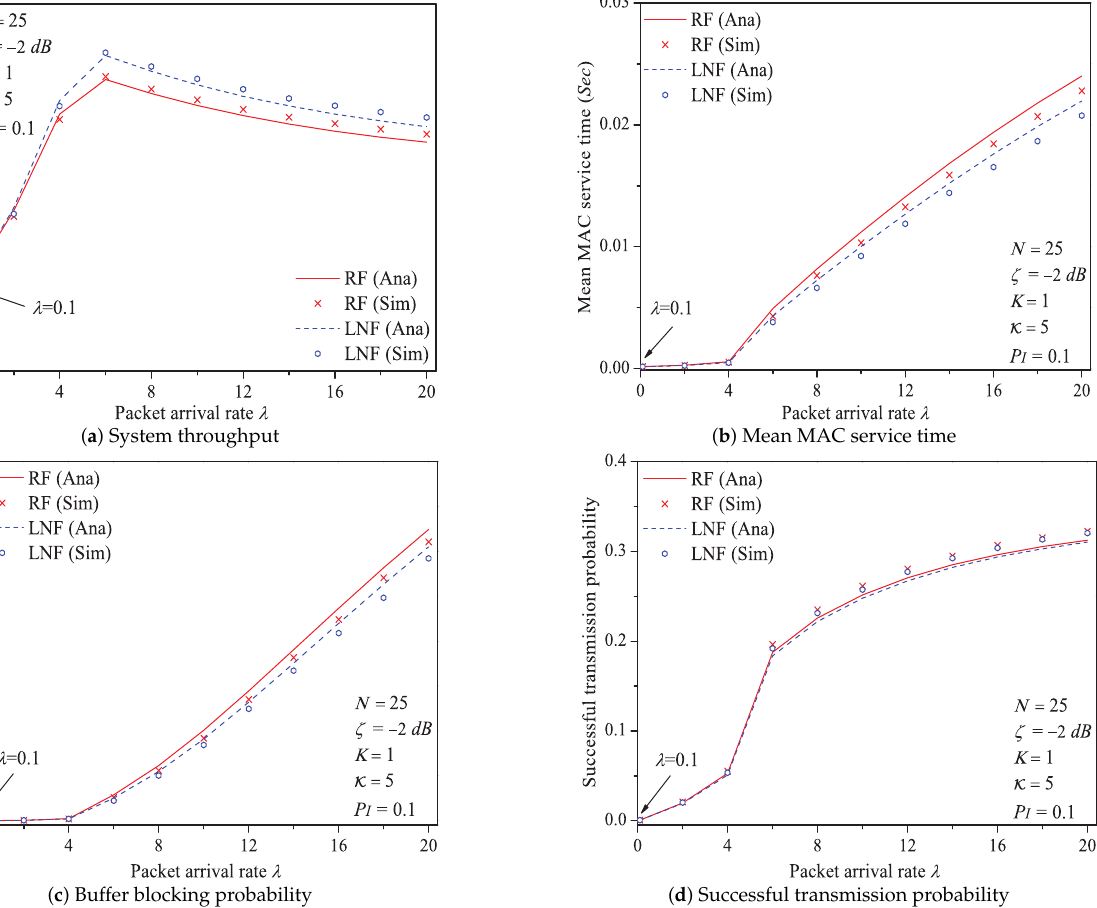
Figure 6. The MAC performance of 1901 protocol with different λ